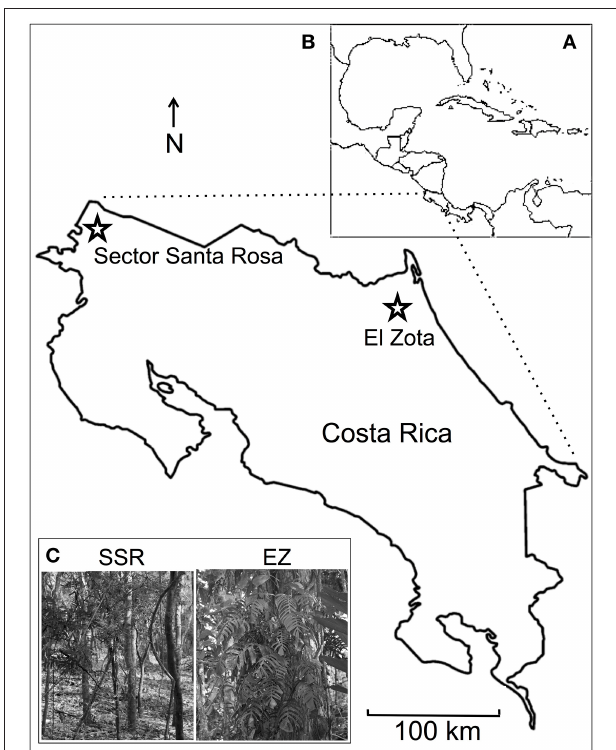
FIGURE 1 | Overview of the study area including maps of (A) Central America, and (B) Costa Rica with study areas highlighted, and (C) photographs of the forests at Sector Santa Rosa (SSR) and El Zota (EZ). Photographs by